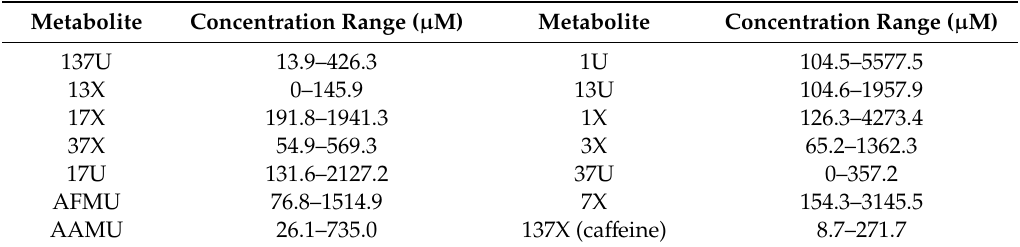
ff eine and its